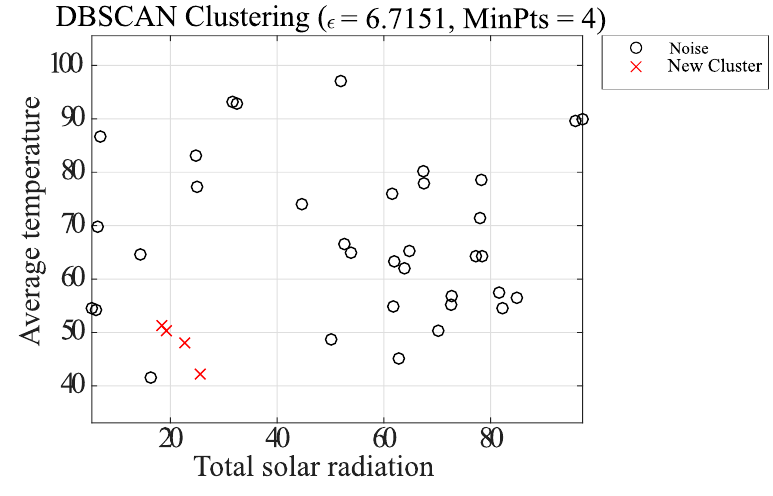
Figure 11. Case 1-6.